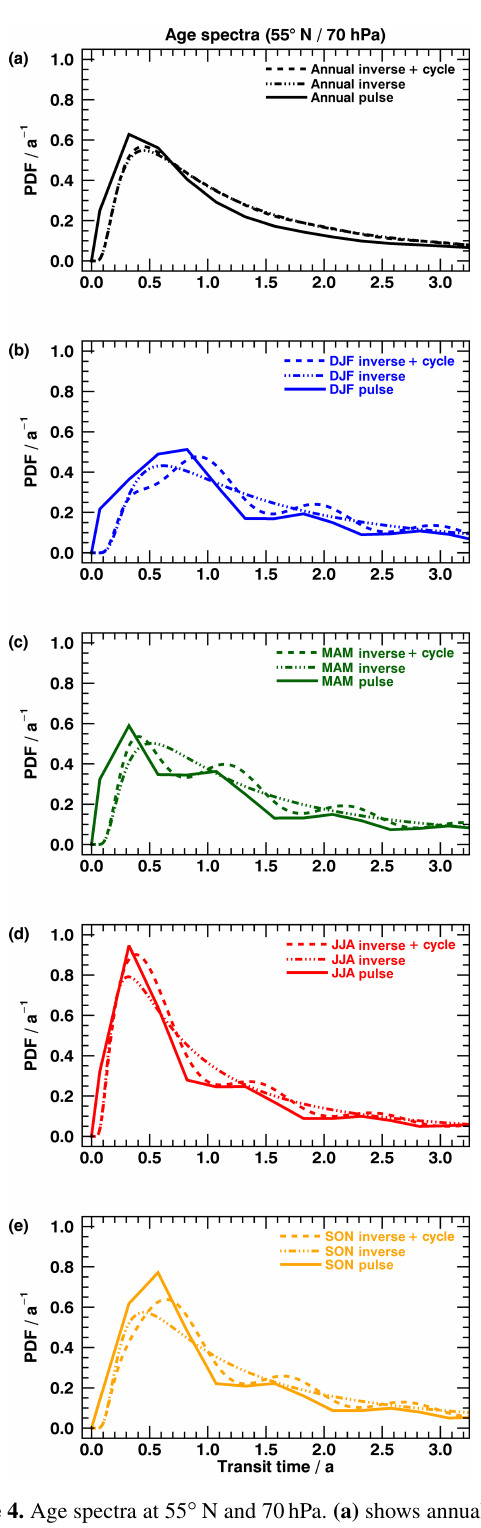
Figure 4. Age spectra at 55 ◦ N and 70hPa. (a) shows annual mean age spectra; (b–e) shows related seasonal spectra. Solid lines repre- sent pulse spectra, dashed lines inverse spectra with seasonal cycle and dashed–dotted lines inverse spectra without seasonal